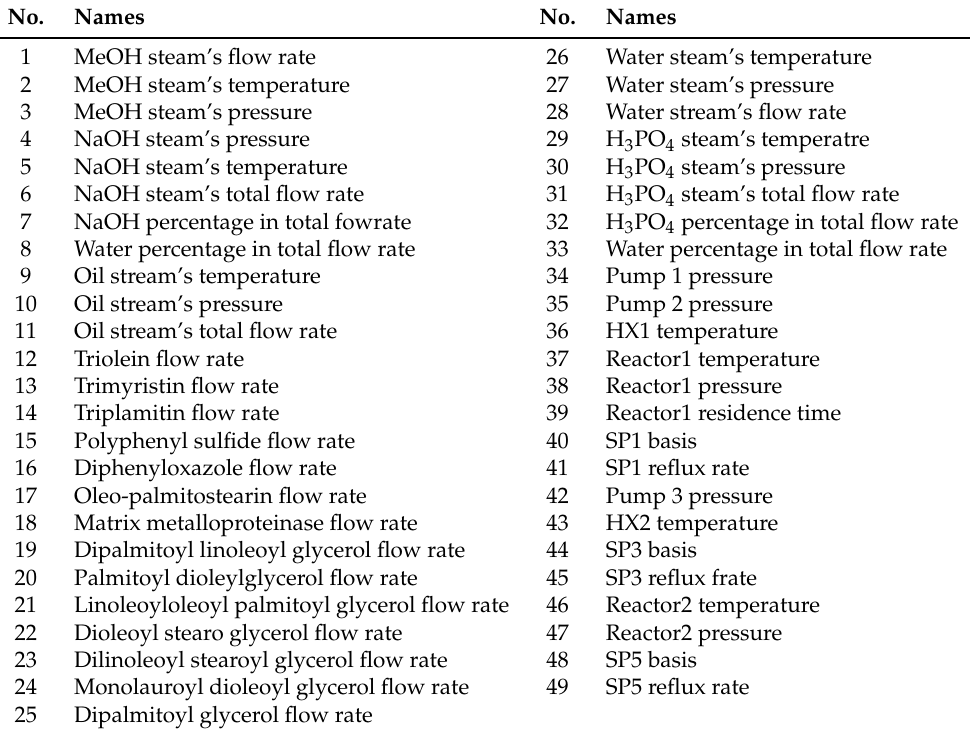
Table 1. Process input variables.